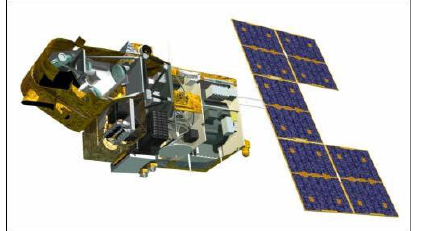
Figure 7. Internal view of the SPOT-4 spacecraft structure